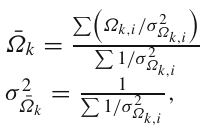
D (cid:2) ( z ) and H ( z ) .